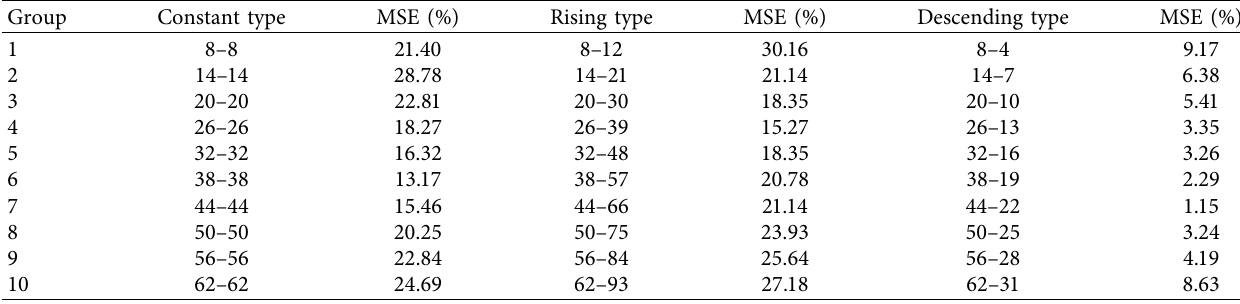
Figure 4: Deep belief network structure. Table 1: Mean square error of different node types in the hidden layer of double hidden layers.